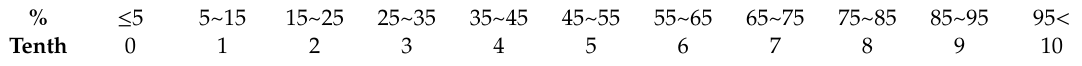
Table 2. Conversion table between the ACOS cloud cover (%) and Daejeon Regional O ffi ce of Meteorology (DROM) human observation cloud cover